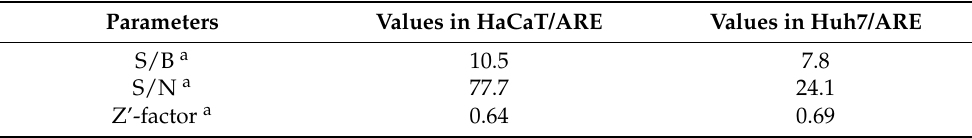
Table 1. Statistical parameters of screening